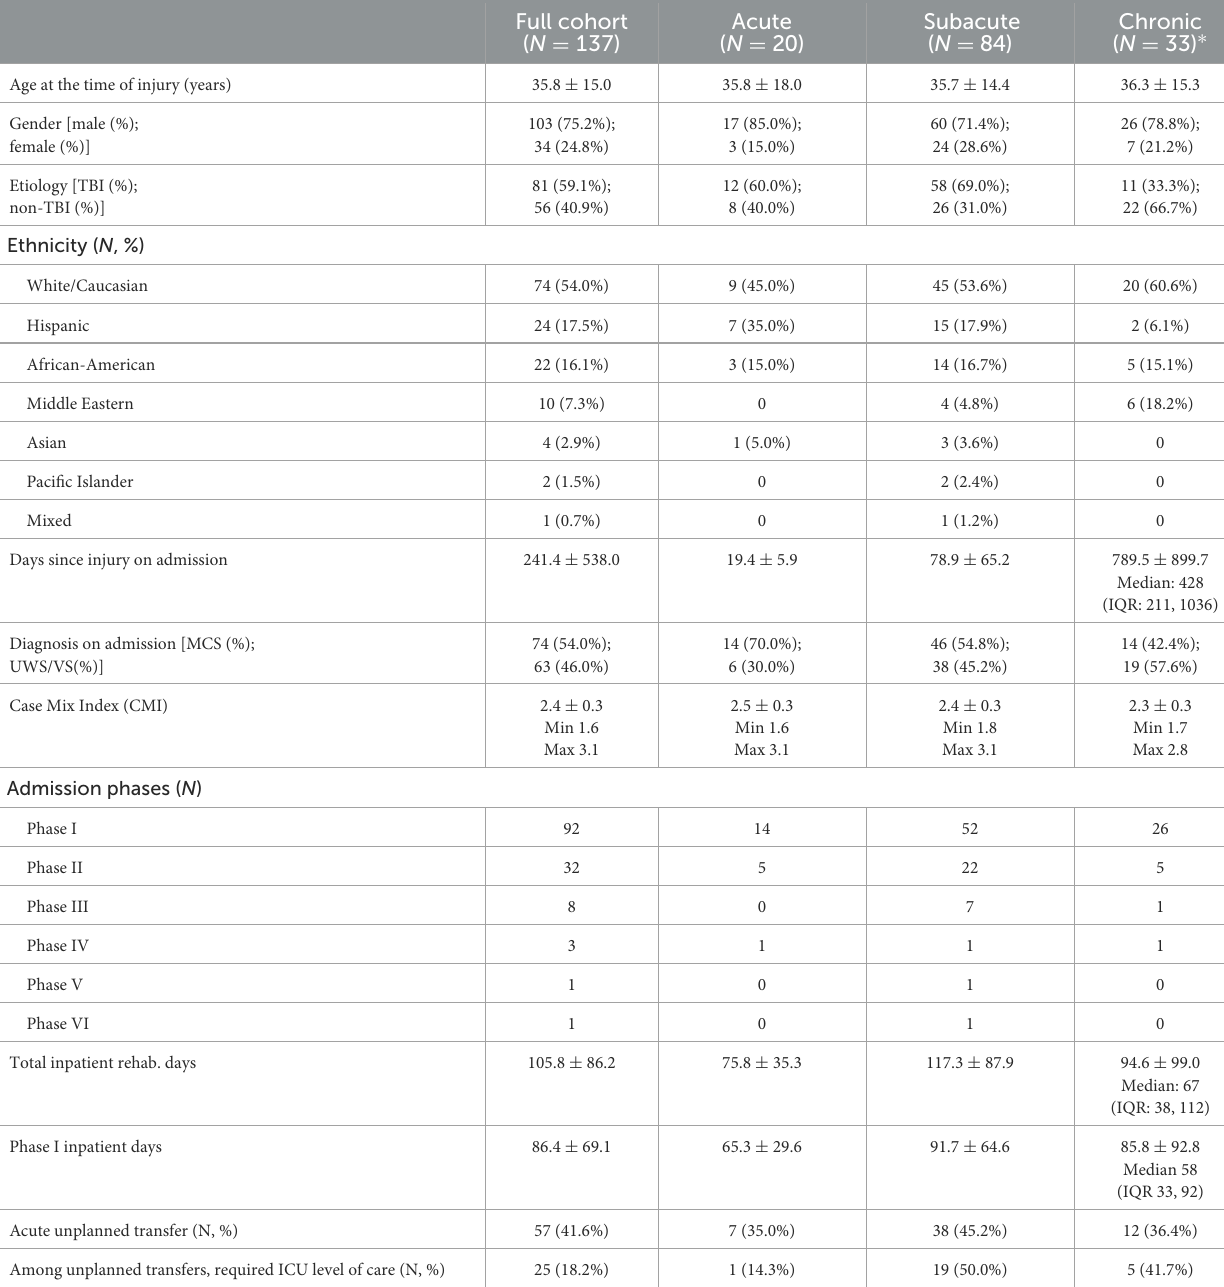
TABLE 1 Demographics and status of all patients admitted at the acute, subacute, and chronic stages.